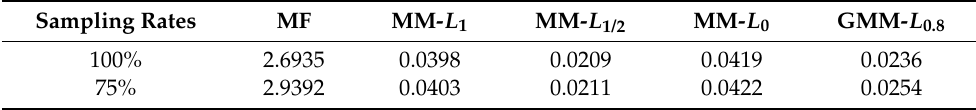
Table 6. The ENT of the Ground-Based Array SAR Data.